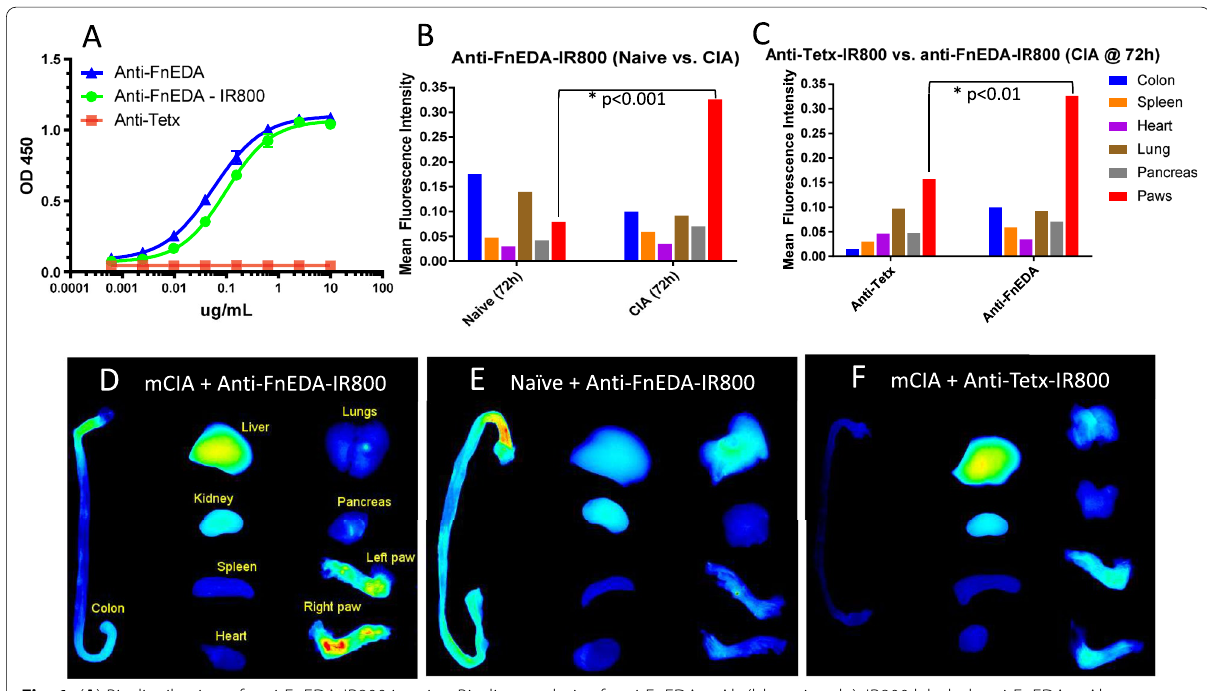
Fig. 1 ( A ) Biodistribution of anti-FnEDA-IR800 in mice. Binding analysis of anti-FnEDA mAb (blue triangle), IR800 labeled anti-FnEDA mAb (green circle) and isotype control anti-TeTx mAb (red square), (N 3 for each data point, with standard deviation bars). ( B ) MFI plots of = anti-FnEDA-IR800 in organs of naïve versus CIA mice, showing significant difference between MFI values between naïve paws and mCIA paws (N 3, p < 0.001). ( C ) Comparison between non-specific anti-TeTx-IR800 and anti-FnEDA-IR800, showing significant difference between MFI values = of anti-FnEDA-IR800 and non-specific anti-Tetx-IR800 in mCIA paws (N 3, p < 0.01). ( D ) Representative ex vivo images of organs from mCIA animals = dosed with anti-FnEDA-IR800, ( F ) naïve animals dosed with anti-FnEDA-IR800 ( E ), and mCIA animals dosed with anti-TeTx-IR800 ( F